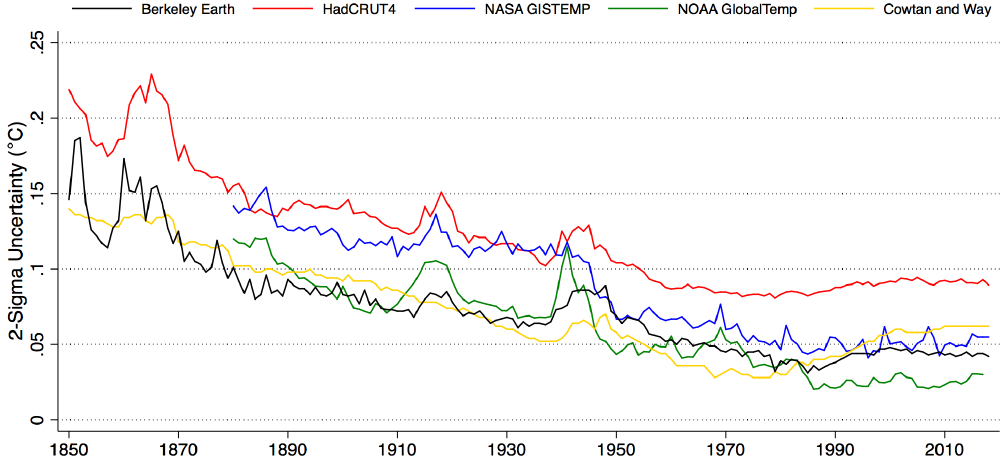
Figure 7. Comparison of published annual uncertainty estimates (two sigma) for Berkeley Earth, HadCRUT4 (Morice et al., 2012), GIS- TEMP (Lenssen et al., 2019), GlobalTempv5 (Vose et al., 2012), and Cowtan and Way